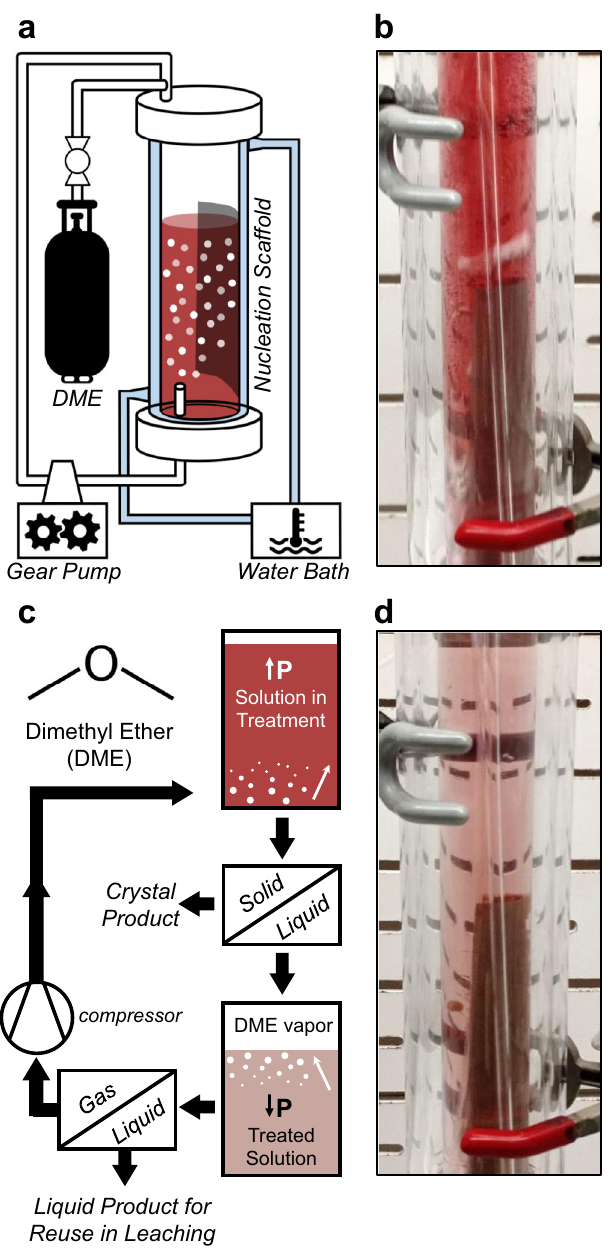
Fig. 1 DME-FC apparatus and process schematic. a Schematic depicting the experimental apparatus whereby DME gas is sparged into an aqueous solution at elevated pressure, permitting dissolution of DME into the liquid. Reaction temperature is controlled via a water bath, recirculation is carried out through a gear pump, and crystallization of metal salts occurs on the nucleation scaffold. b Photograph of the experimental apparatus during treatment of the Sm-Co leachate. c Process schematic depicting the DME- FC solid-liquid separation followed by a gas-liquid separation to recover and reuse DME with high ef fi ciency. d Photograph of the experimental apparatus after FC of CoSO 4 from the leachate, showing the visible change in CoSO 4 concentration concurrent with crystal growth on the nucleation fi ttings, valves, and tubing permits DME sparging of the leachate within the inner chamber while reaction temperature is con- trolled in the outer chamber via a water bath. In the photograph shown in Fig. 1b, the solution becomes saturated with DME, inducing crystallization that occurs primarily on the nucleation